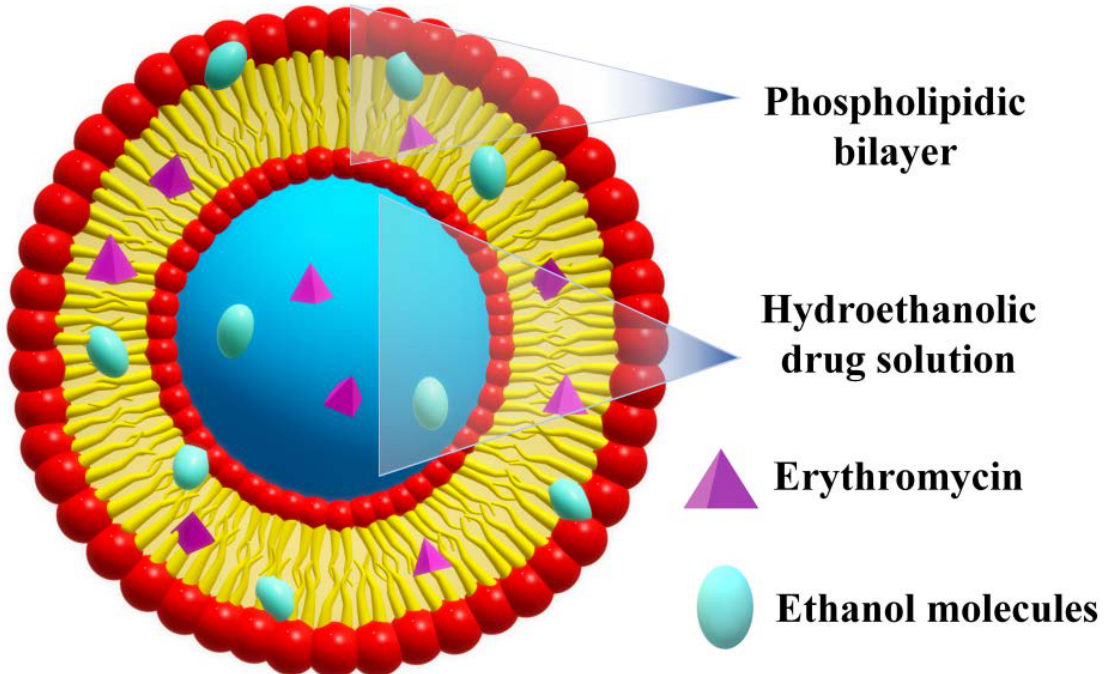
Figure 4 . Schematic representation of an ERY ethosome. Figure 4. Schematic representation of an ERY